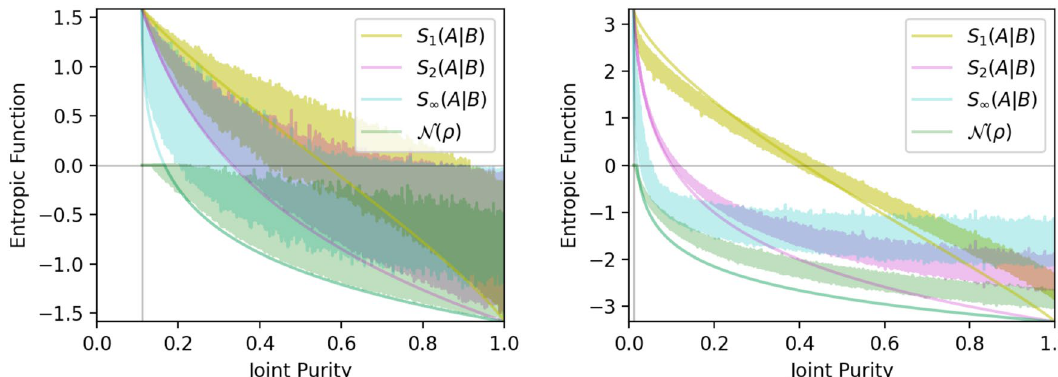
Figure 2. Plots showing different conditional entropy functions (and the negativity) for uniform-purity ensembles as a function of joint purity. (Left) Case of 3 curves of the same color plot the corresponding function of the Werner state whose purity is varied by changing the mixing parameter p . Note that the Werner state curves for negative the log negativity the conditional min entropy S